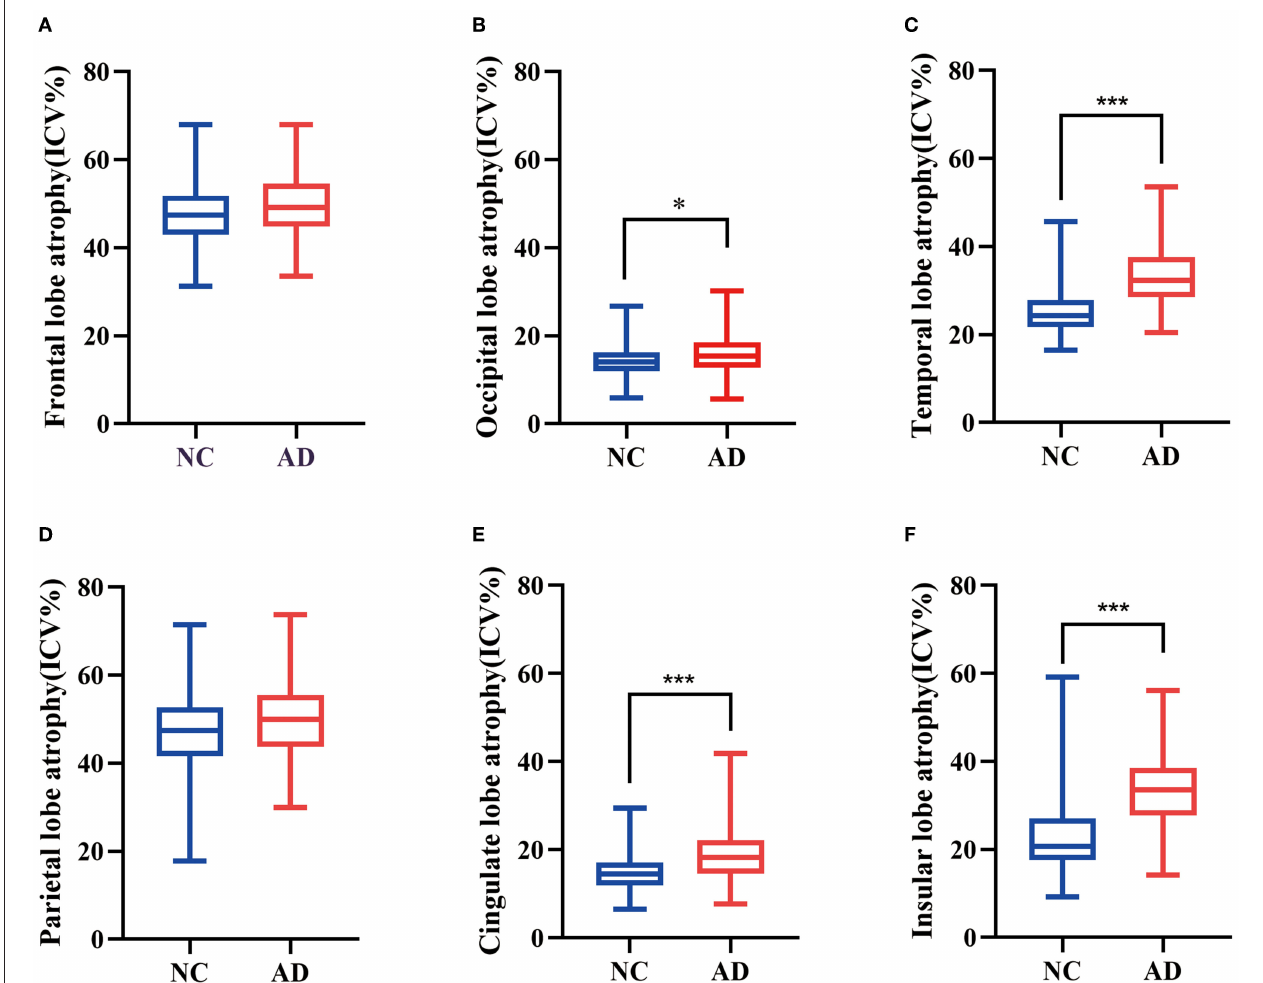
FIGURE 3 | Box plots were used to show the difference of quantitative regional brain atrophy between AD and NC. Frontal lobe atrophy (A) and parietal lobe atrophy (D) showed no significant difference between the two groups. Occipital lobe atrophy (B) , temporal lobe atrophy (C) , cingulate lobe atrophy (E) , and insular lobe atrophy (F) were more serious in AD than NC. * P < 0.05, *** P <